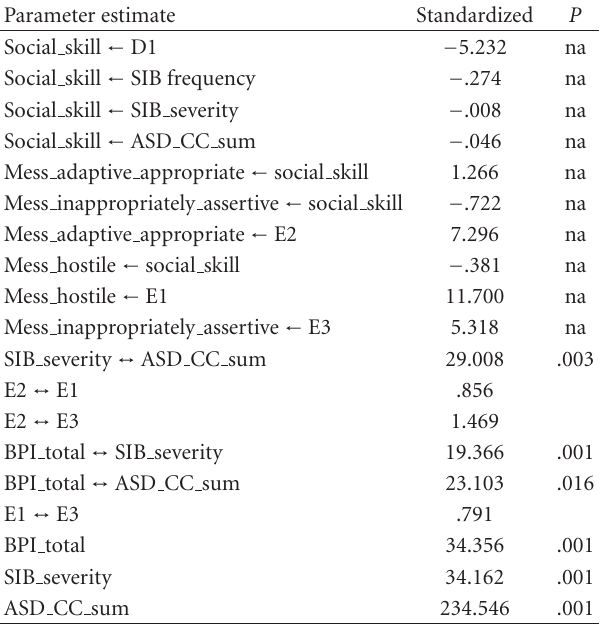
Table 2: Summary of standardized coe ffi